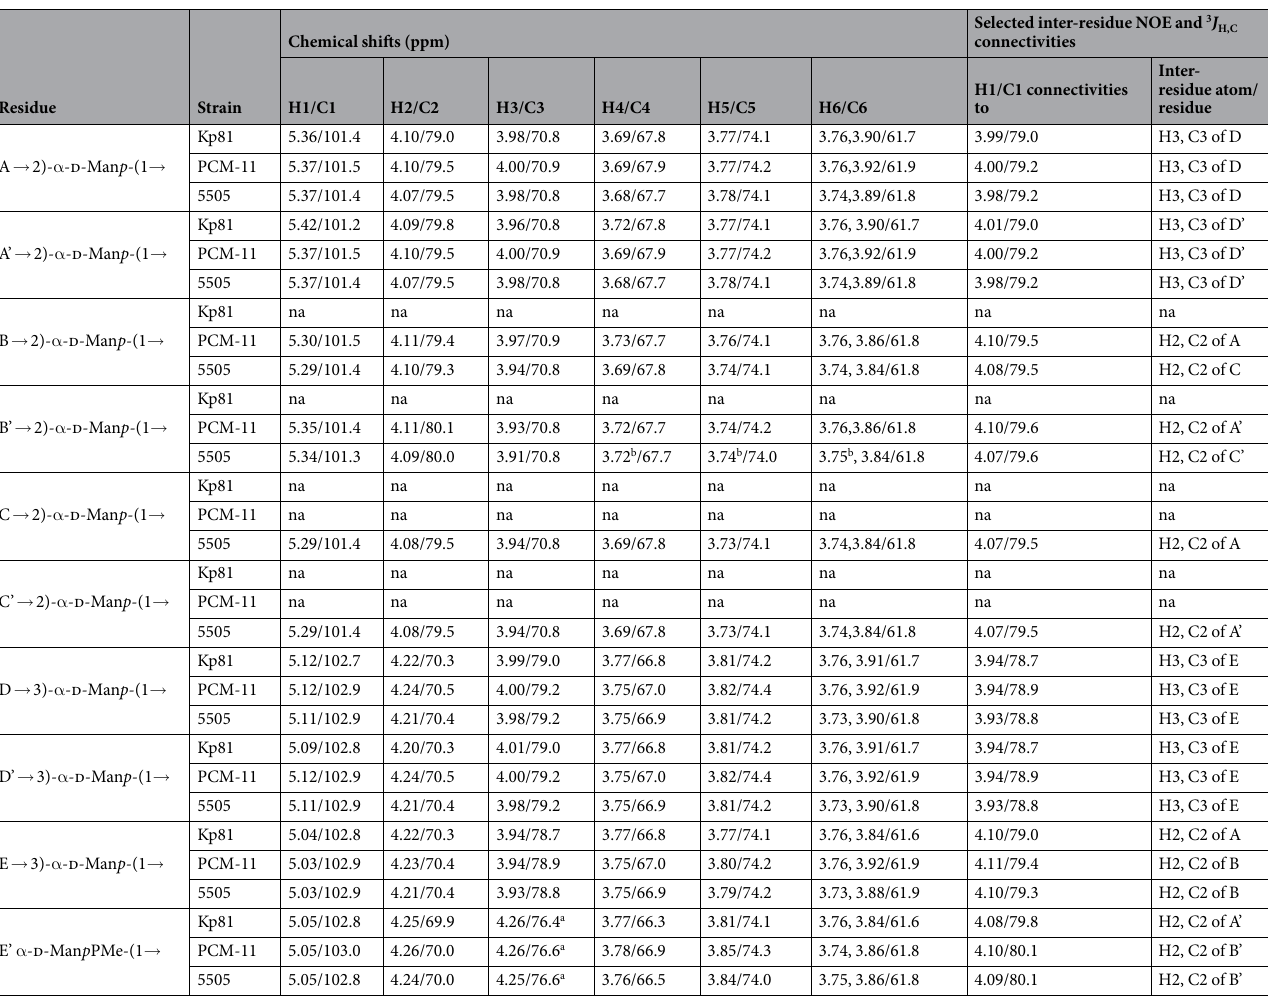
Table 1. 1 H and 13 C NMR chemical shifts and selected inter-residue NOE and 3 J H,C connectivities from O-PS isolated from K. pneumoniae Kp81, PCM-11, and 5505 Δ cps . a MeP was identified in Kp81: 3.61, 3.63/53.7 ppm; in PCM-11: 3.61, 3.63/53.9 ppm; and in 5505 Δ cps : 3.61, 3.63/53.8 ppm, where J P,H was 11.0 Hz. 31 P, 1 H HMBC showed correlation between P (~2 ppm) and protons of MeP and H-3 of E’ residues. 31 P, 1 H HMQC-TOCSY showed correlation between P and H-1, H-2, H-3, H-4, H-5 of E’ residues. Anomeric configuration ( α ) of sugar residues was determined on the basis of J H1,C1 of 171-174 Hz. b Assignments of resonances were made by comparisons with published data 12 . na- not applicable for indicated